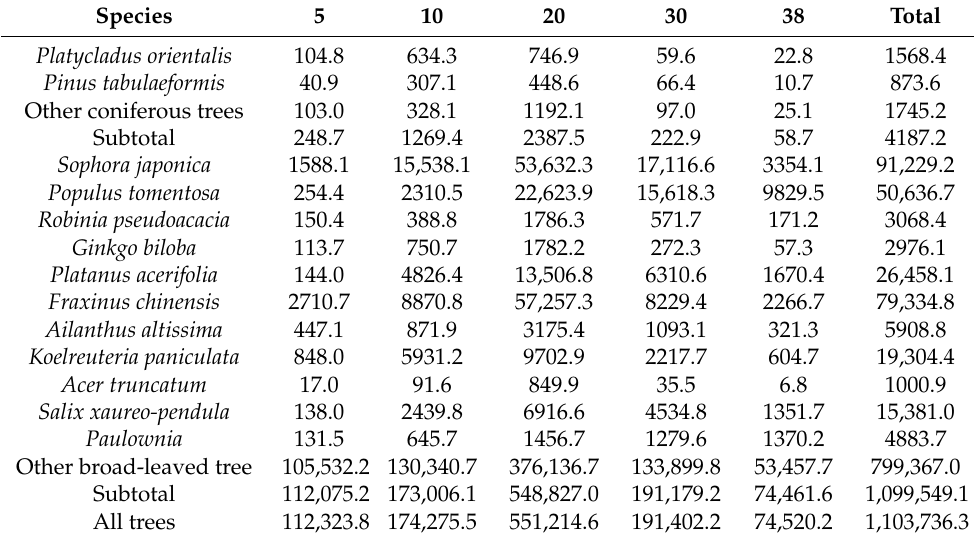
Table 9. Annual water consumption of all trees in Beijing (10 3 m 3